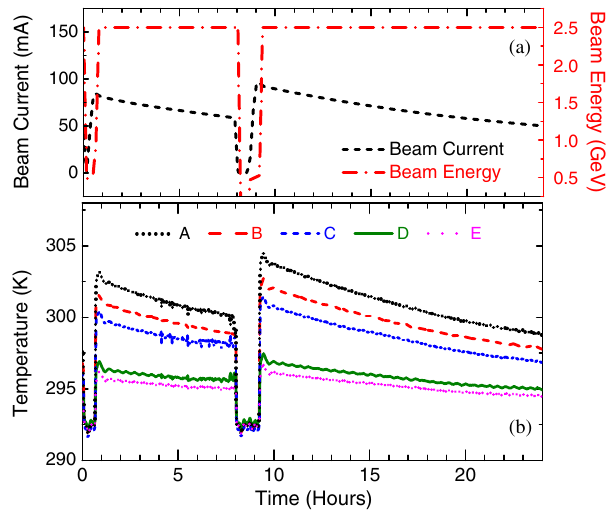
FIG. 14. Evolution as a function of time, during a 24 h KARA working cycle, of (a) beam energy (red line) and beam current (black line) and (b) temperatures measured at PT100 A (black line), B (red line), C (blue line), D (green line), and E (pink